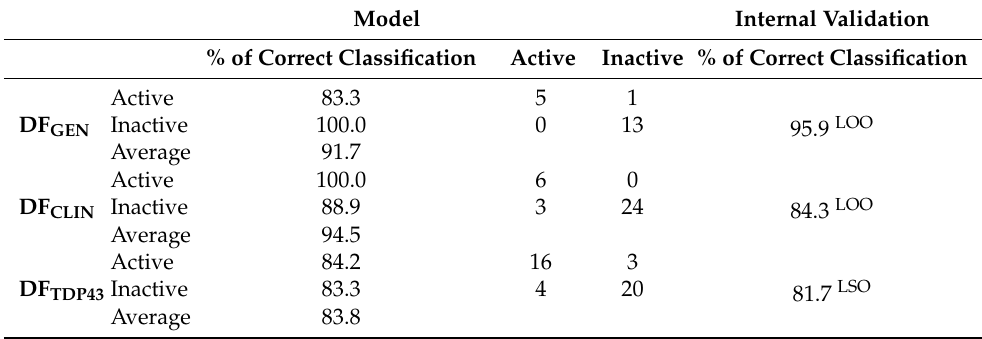
Table 2. Classification matrices for the ALS models and internal validation (LOO and